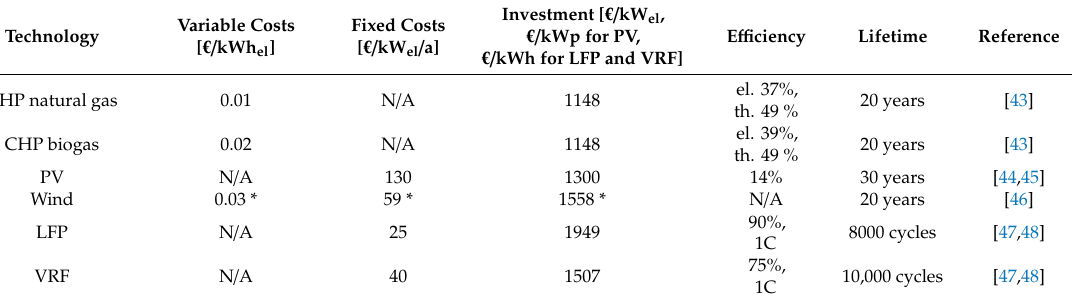
Table 1. Costs, e ffi ciency and lifetime of the di ff erent